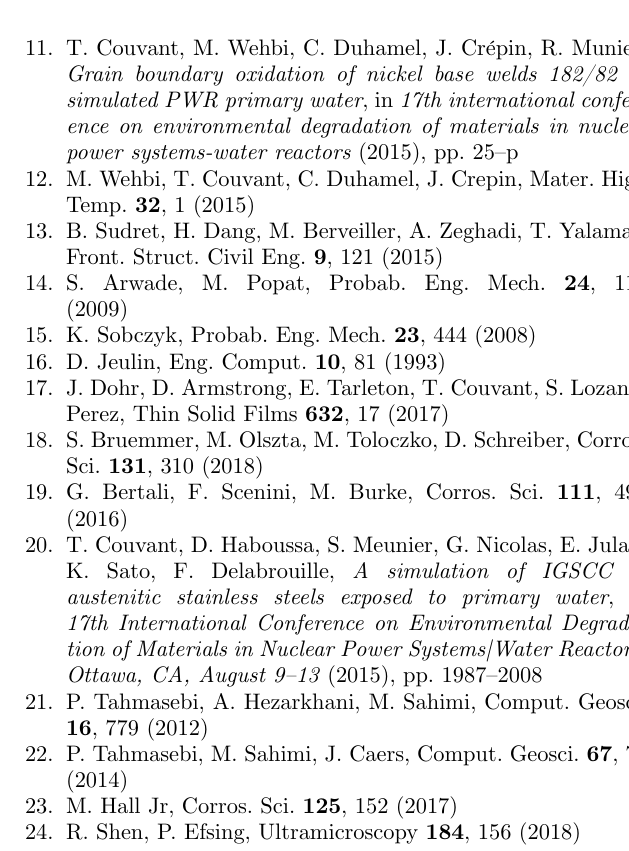
Fig. A.2. Stitching process: the 2 OL regions are first defined (1.), the error is then computed between these 2 regions (2.) and a continuous path of minimum error is built (3.). The 2 images are cut along this path (4.) and finally stitched together, with a smooth boundary